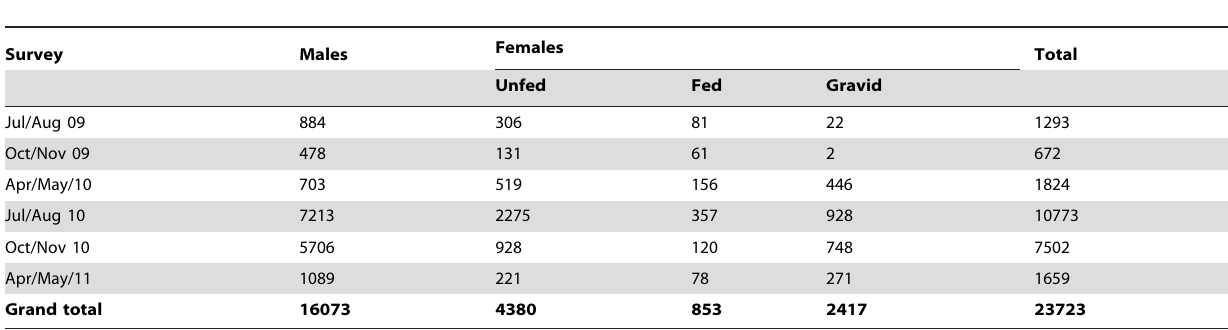
Table 1. Overview of Phlebotomus argentipes captured by sex and sampling period.